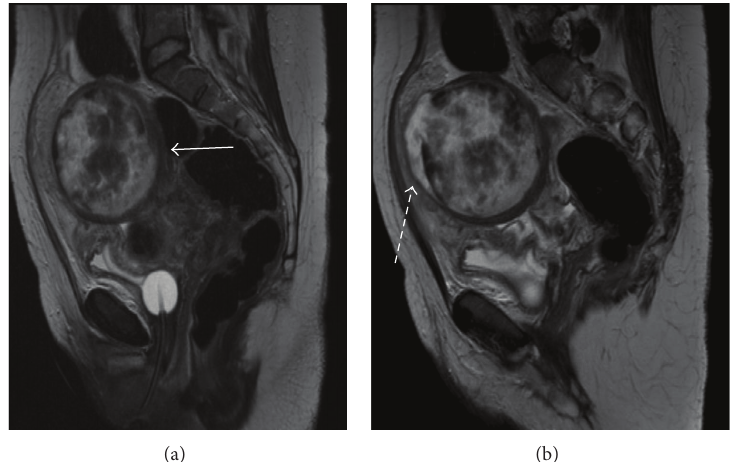
Figure 1: MRI of the PELVIS. (a) Necrotic 8.2 cm subserosal fibroid [arrow]. (b) Necrotic 8.2 cm subserosal fibroid with an encapsulated collection lying anterior to the fibroid suggesting rupture [dashed